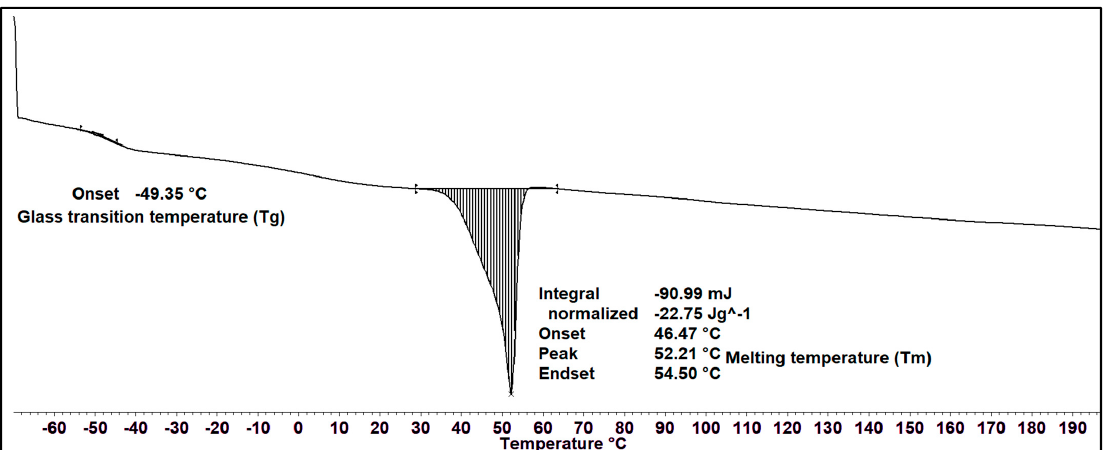
Figure 6. DSC thermogram of MCL-PHA terpolyester sample at the heating rate of 10 °C/min.